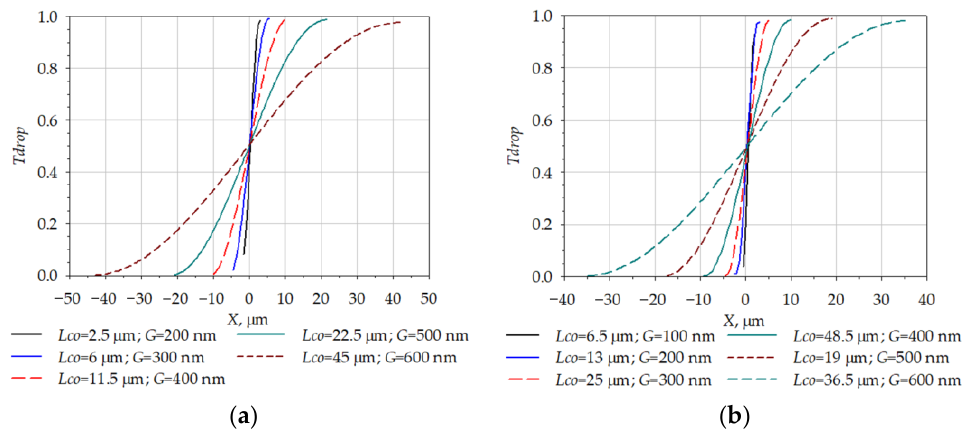
Figure 12. Dependence of the optical transmission coefficient on the inertial mass linear displace- ment along axis X for the OMT with different-plane waveguides (Scheme 8). ( a ) Waveguides with dimensions of 300 × 1000 nm; ( b ) Waveguides with dimensions of 300 × 750 nm.